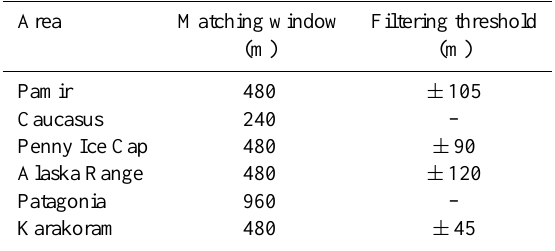
Table 4. Matching window sizes and filtering thresholds in the dif- ferent